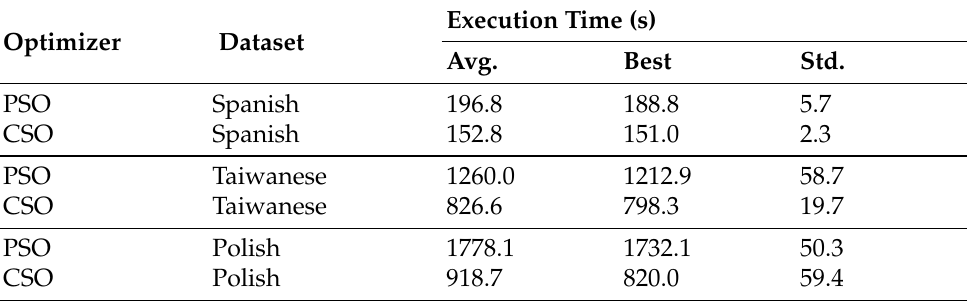
Table 11. A comparison of the PSO and CSO execution